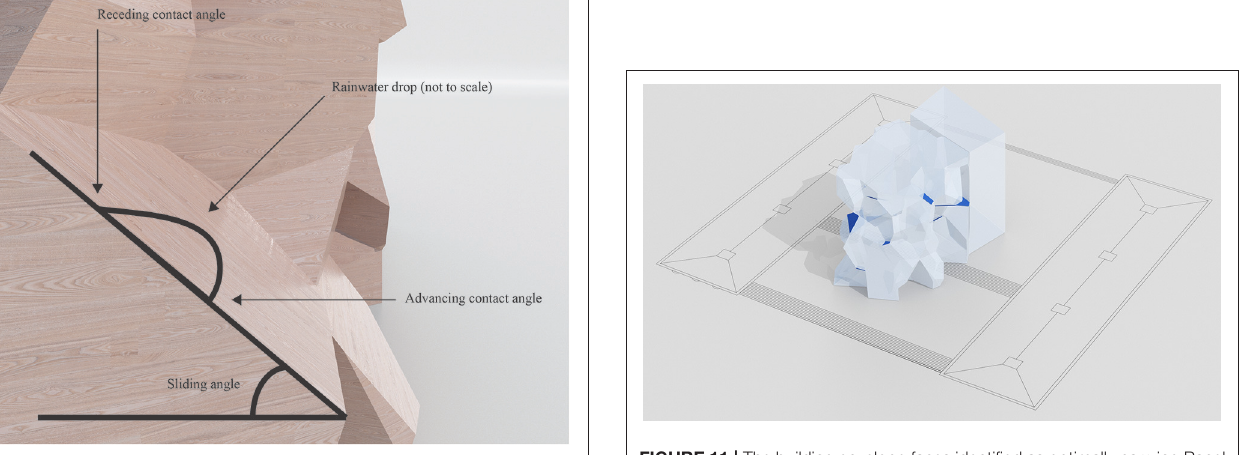
FIGURE 10 | The principle of contact angle hysteresis.